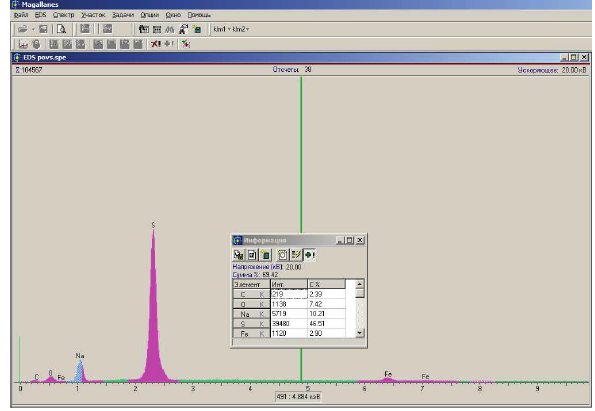
Fig. 3. The spectra of X-ray energy dispersive analysis are averaged from the microfield